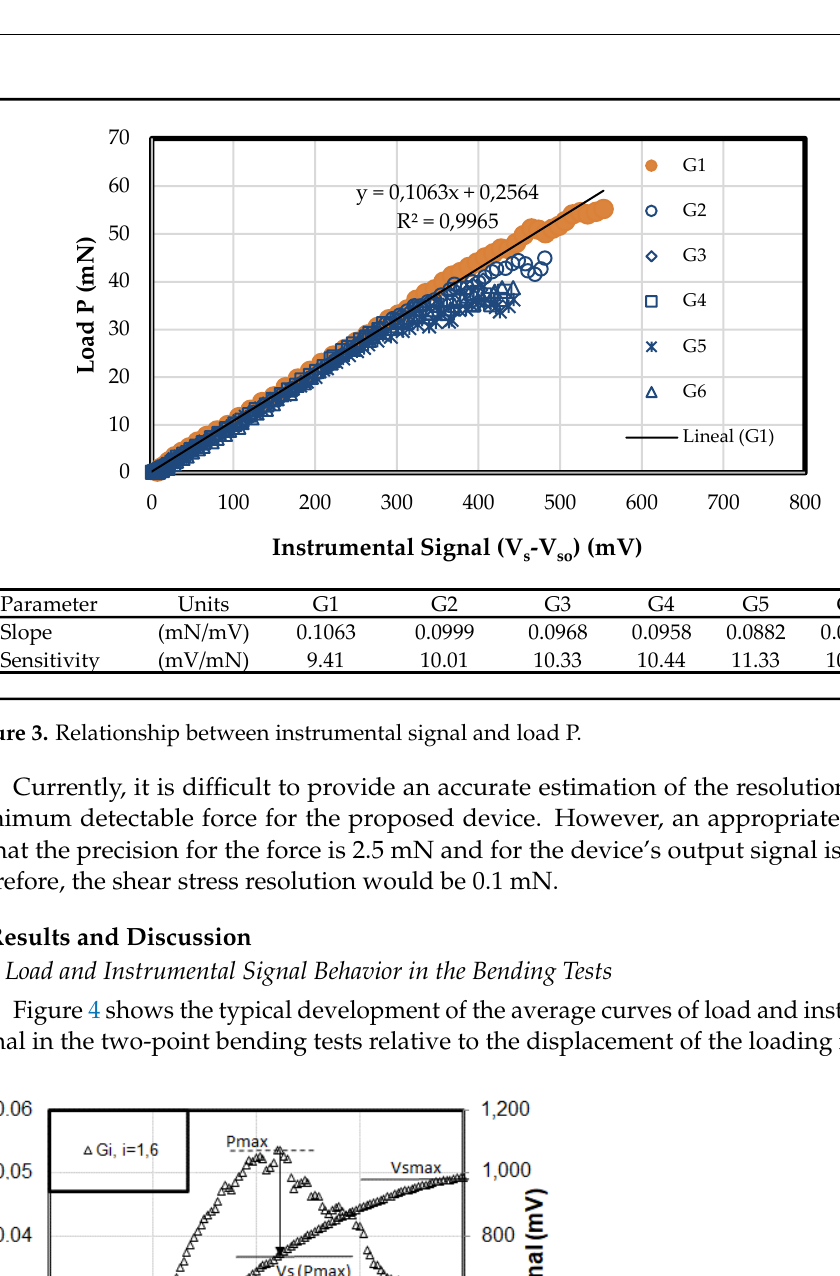
Table 2. Experimental values of generic parameters for load and instrumental signal. Sensor